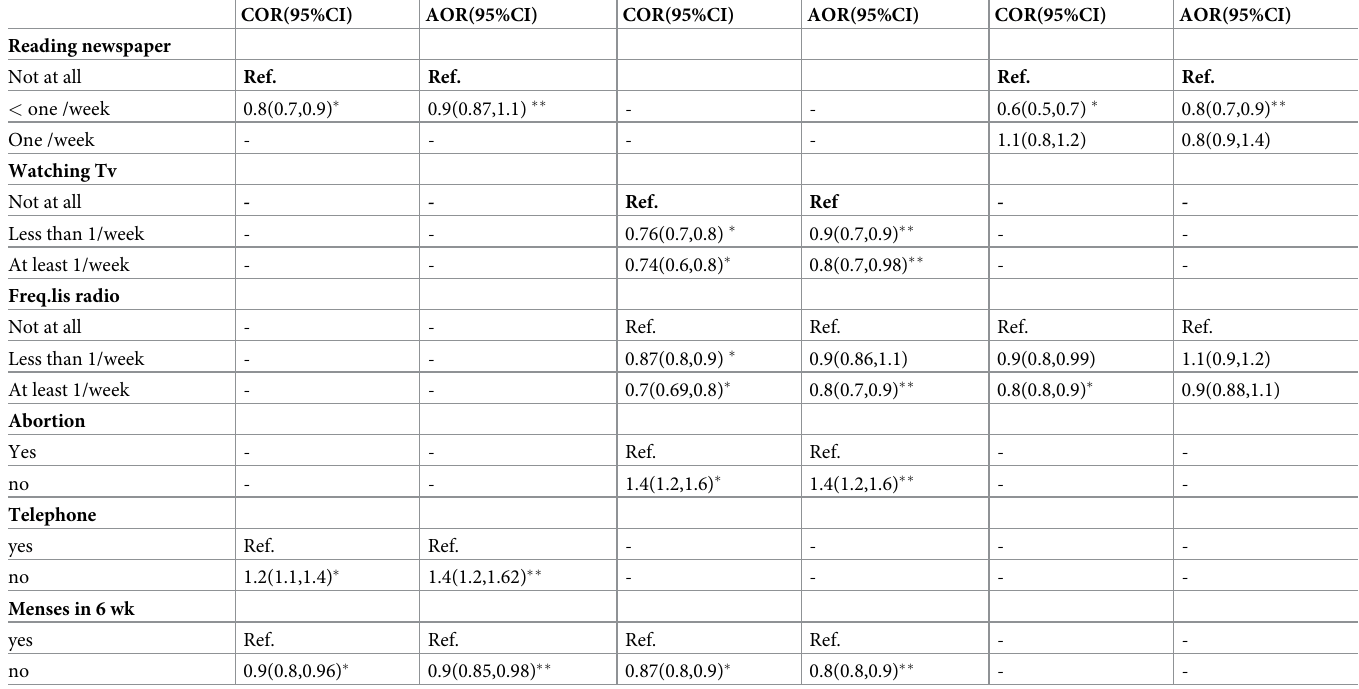
Table 6. Source of information and women reproductive health characteristics.